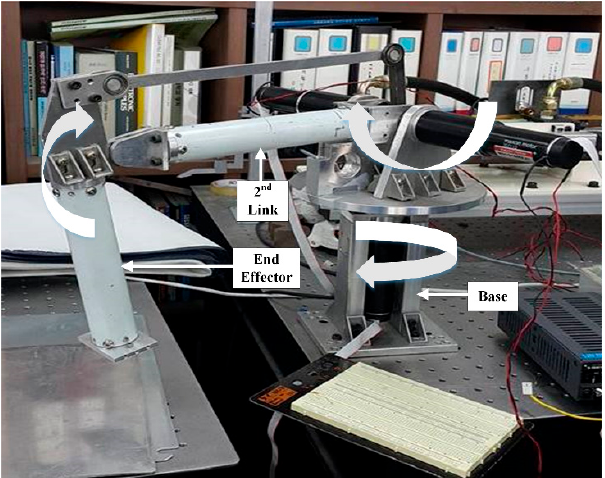
Figure 6. Master device.